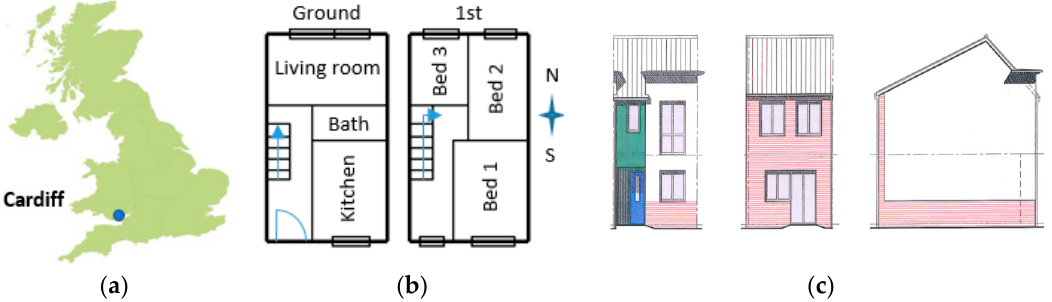
Figure 1. ( a ) Location of the house in the UK map; ( b ) Floor plans; ( c ) Elevations of the